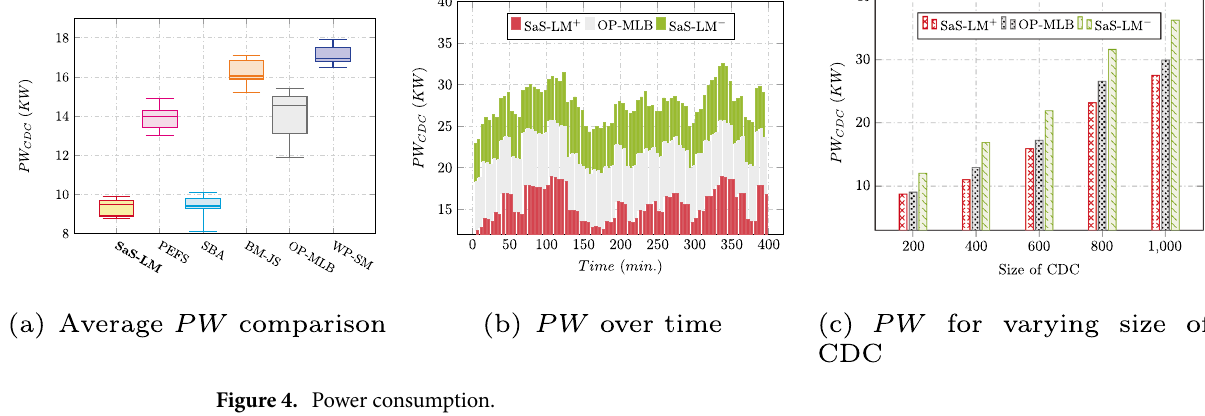
Figure 4. Power consumption.